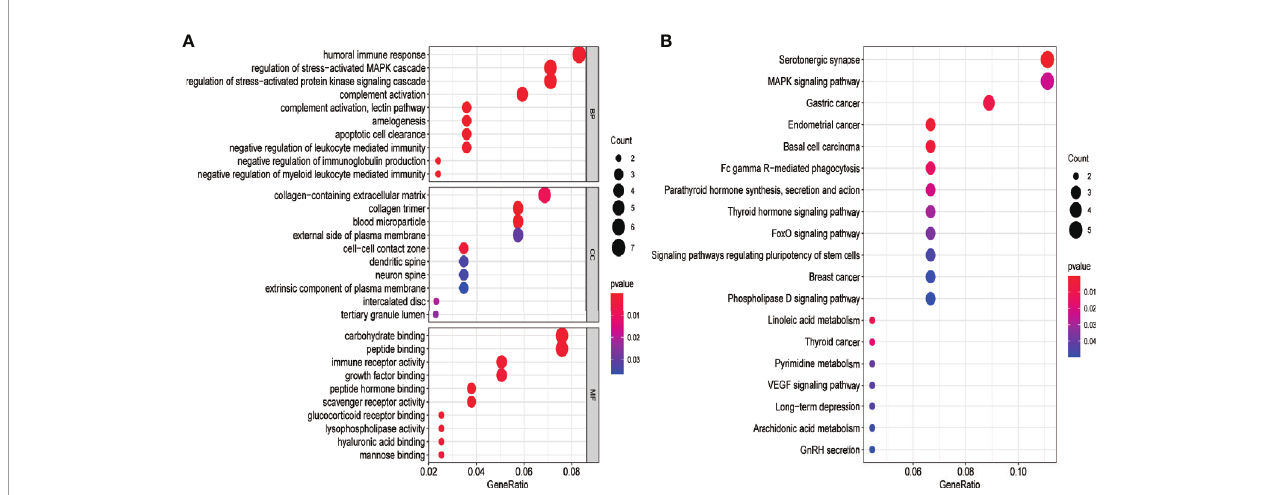
FIGURE 7 | GO and KEGG pathway analysis of the 87 genes. (A) GO analysis; (B) KEGG pathway analysis. GO analysis includes biological process (BP), cellular component (CC), and molecular function (MF). The count represents the number of genes and the color represents the adjusted